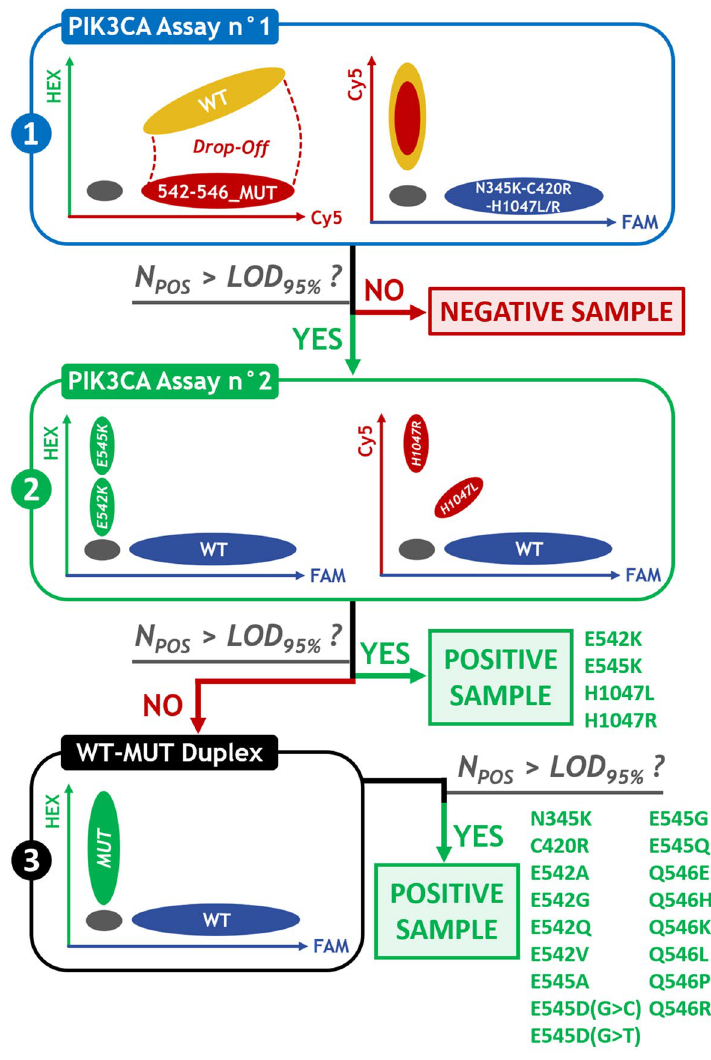
Figure 4. Diagnostic strategy for PIK3CA mutations identification. The PIK3CA Assay n°1, covering 90% of the PIK3CA mutations reported in the COSMIC database for breast carcinoma tumor samples, was performed as a first-line screening assay; followed, in case of a postive result, by the PIK3CA Assay n°2 focusing on the four most frequent PIK3CA mutations. Lastly, WT-MUT duplexes were performed for the identification of the less frequent